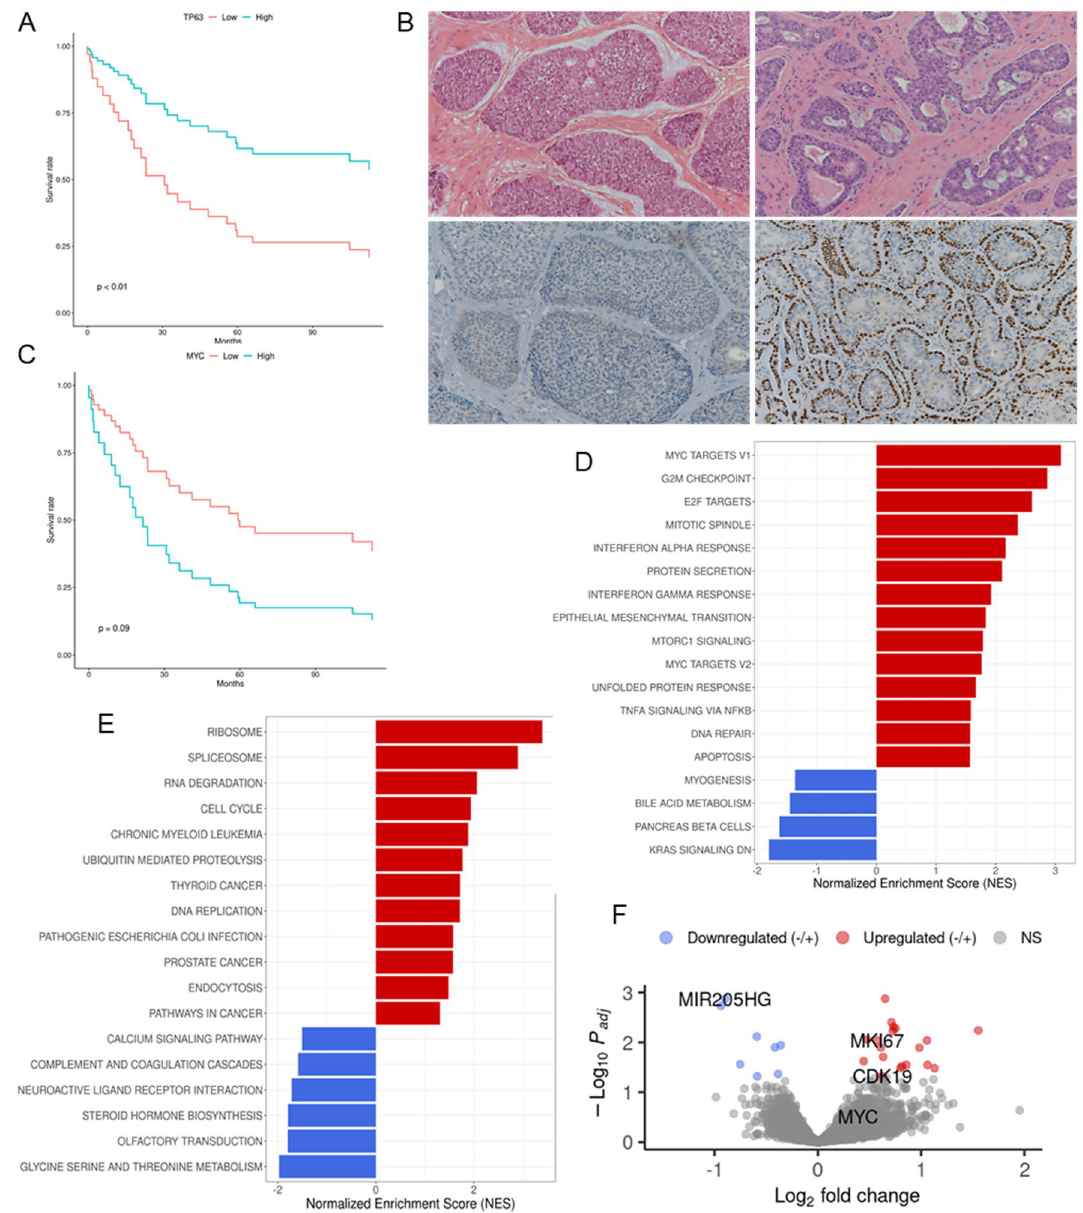
Figure 2. Distinct transcriptional features are associated with p63-negative ACC. ( A – C ) Kaplan–Meier curves showing the DFS as a function of TP63 or MYC mRNA expression. p-value computed from Likelihood Ratio Test (LRT). ( B ) Representative cases of ACC showing either diffuse strong nuclear p63 immunostaining in more than 70% of tumor cells (low right panel) or completely negative p63 expression (low left panel). Corresponding H&E sections are shown in the upper panel (10 × magnification). ( D , E ) Functional enrichment analysis depicting biological processes up-regulated in p63 neg ACC group compared to p63 pos tumors, considering both Hallmark and KEGG genesets. Each distribution represents the t-statistic associated to the core-enrichment genes of each pathway. ( F ) Volcano plot of genes with increased expression in p63 neg (red dots) and p63 pos (blue dots)